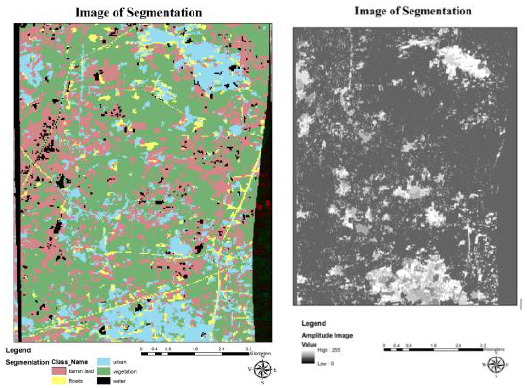
Figure 17 . Fused and Amplitude Segmented Image